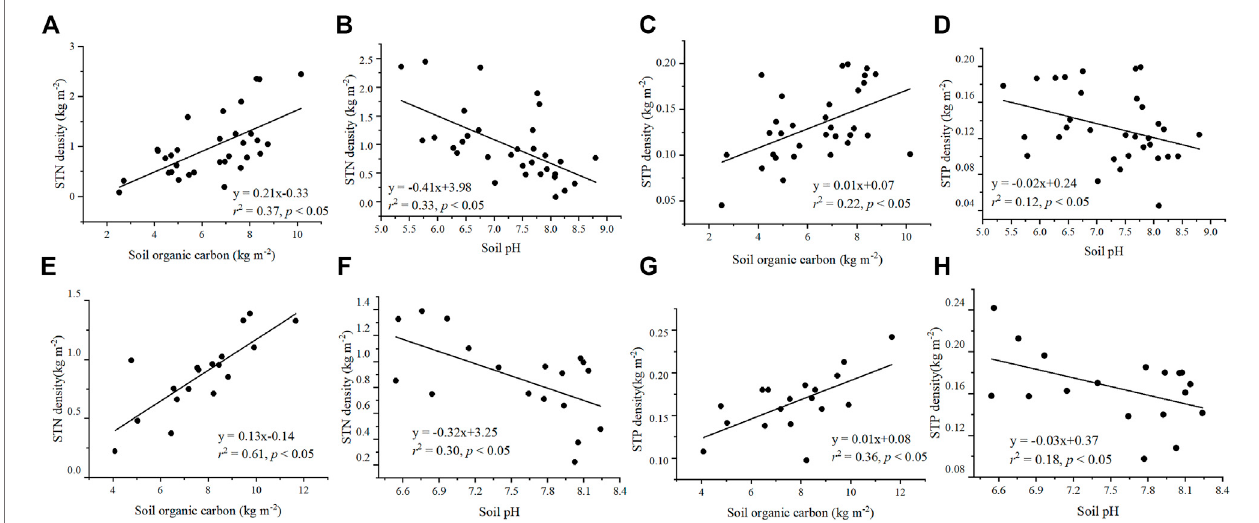
FIGURE 1 | Relationships of STN density and STP density with soil variables, including soil organic carbon and soil pH. The relationships of STN density in alpine wetlands (A,B) and alpine meadow (E,F) with soil organic carbon (A,E) and soil pH (B,F) . The relationships of STP density in alpine wetlands (C,D) and alpine meadow (G,H) with soil organic carbon density (C,G) and soil pH (D,H) . STN density, soil total nitrogen density; STP density, soil total phosphorus density.